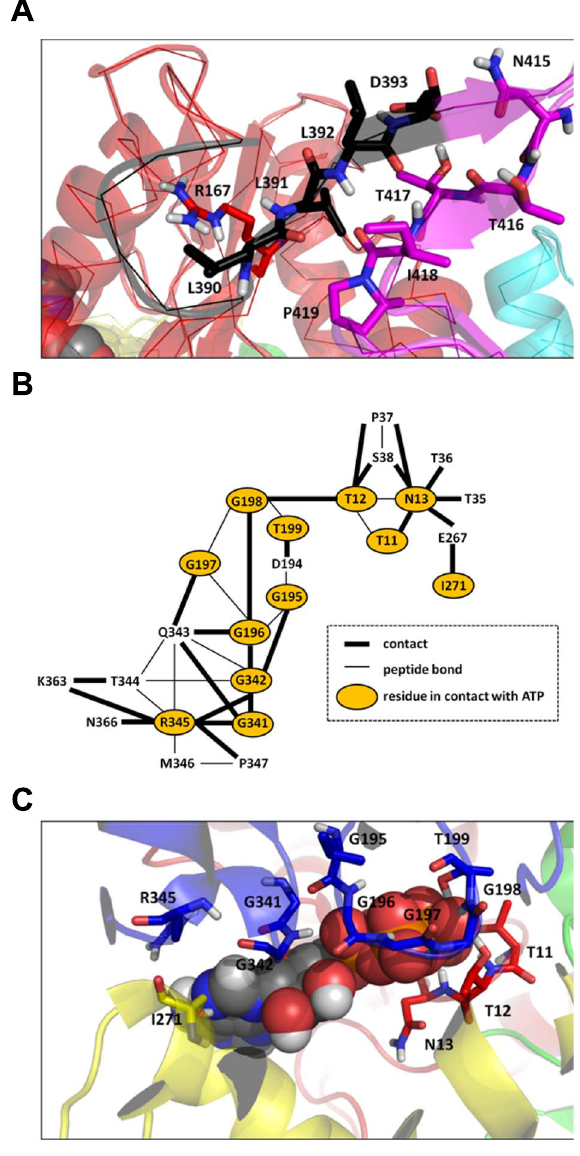
Figure 4. Contact maps from ATP-bound and ADP-bound MD trajectories. A: Interdomain interactions extracted from the contact map difference ATP/ADP (see text for details). Residues involved in the interdomain interactions are shown in stick representation. The color code is the same as in Fig. 1. B: Interactions between the ATP nucleotide and the NBD of DnaK from ATP-bound MD trajectories. C: Three- dimensional representation of the interactions between ATP and the NBD. Residues of the NBD in contact with ATP are shown in stick representation. The color code of the protein structure is the same as in Fig. 1. These figures were prepared with PyMOL [http://www.pymol. org].